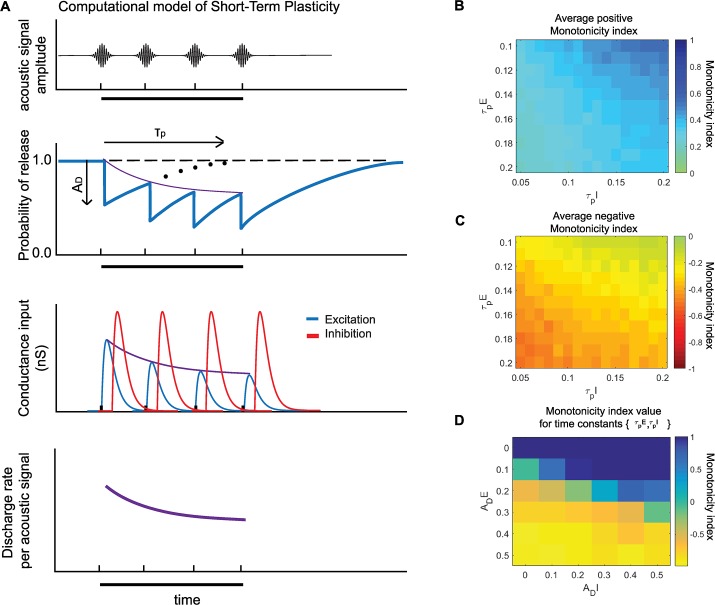
Computational model of an auditory cortical neuron with short term depression.(A.) At each acoustic signal (top) we simulate the decrease in the probability of release of synaptic vesicles with an amplitude of adaptation AD followed by an exponential recovery with time constant τp (middle top) (See methods for details). This probability of release then determined the amplitude of conductance input to our model neuron (middle bottom). a decrease in conductance amplitude during stimuli presentation (black bar) resulted in a decrease in discharge rate per acoustic signal (bottom). (B-D.) Adaptation parameter space. Average positive (B.) and negative (C.) monotonicity index for a given set of recovery time constants {τpE, τpI}. Average monotonicity index at {τpE = 0.15, τpI = 0.10} for different values of ADE and ADI (D.).